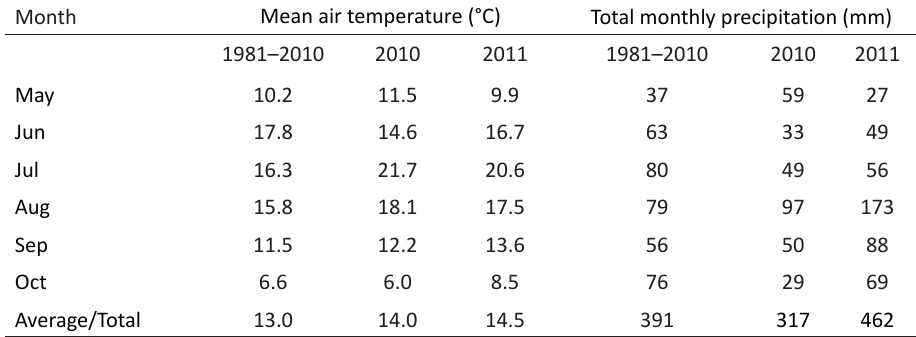
Table 1. Mean air temperature (°C) and total monthly precipitation (mm) in Helsinki May to October 2010 and 2011 (FMI 2010–2011), compared with long term average (1981 – 2010) at Kaisaniemi,